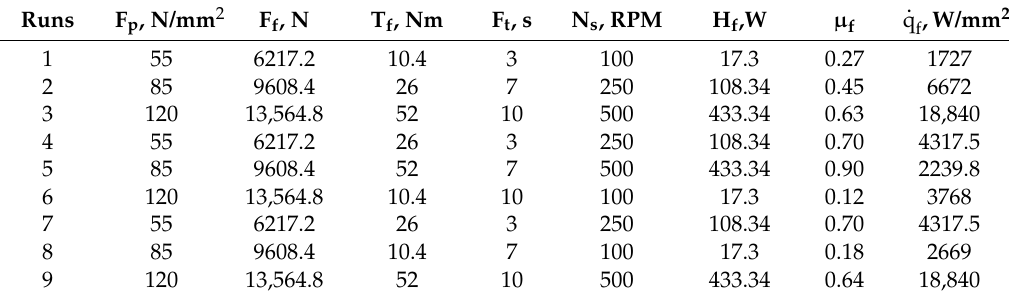
Figure 5. Input and output parameters of the friction welding process. Table 6. Critical friction welding parameters used in the